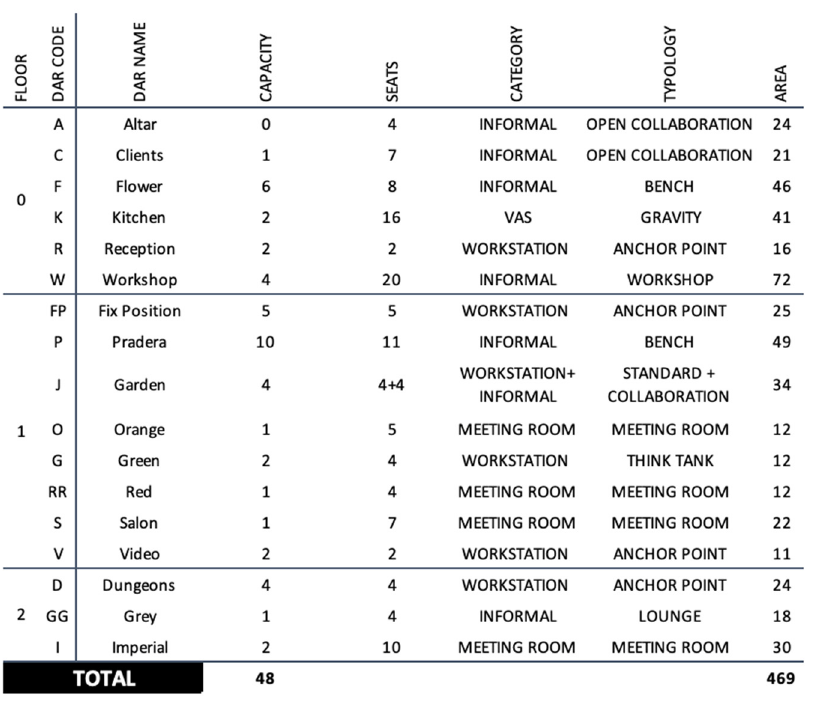
Figure 5. Office spaces per category, indicating floor, code, name capacity, number of seats, category typology, and total area in m 2 .